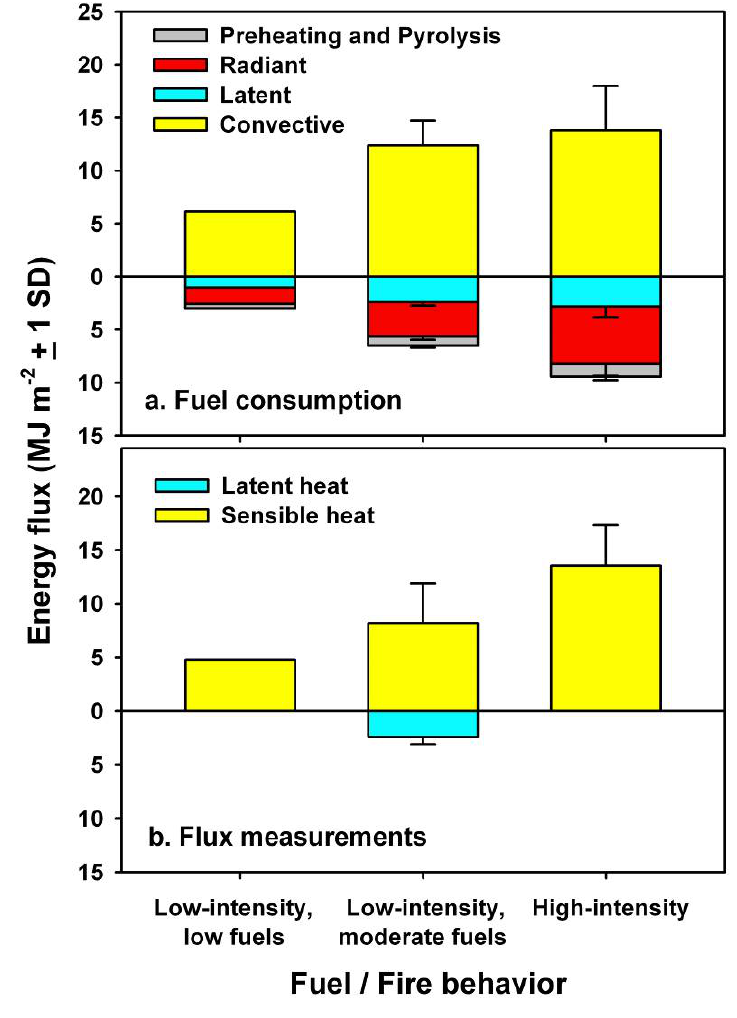
Figure 4. Estimated energy fluxes during the eight prescribed fires, separated by low-intensity fires with relatively low fuel loading, low-intensity fires with moderate fuel loading, and high-intensity fires. ( a ) Energy release calculated from consumed fuels, partitioned into energy consumed during preheating and pyrolysis of fuels, and radiant, latent, and convective heat fluxes. Values for preheating and pyrolysis of fuels, radiant heat flux and latent heat flux are shown below the zero-line to facilitate comparison between convective and ∆ sensible heat fluxes. ( b ) ∆ Sensible and ∆ latent heat fluxes calculated from integrated eddy covariance measurements at burn area and control towers. ∆ Latent heat fluxes were measured above burn area and control towers at the three low-intensity fires with moderate surface and understory fuels only. Only two low-intensity fires with low fuel loading were conducted thus no error terms are presented.